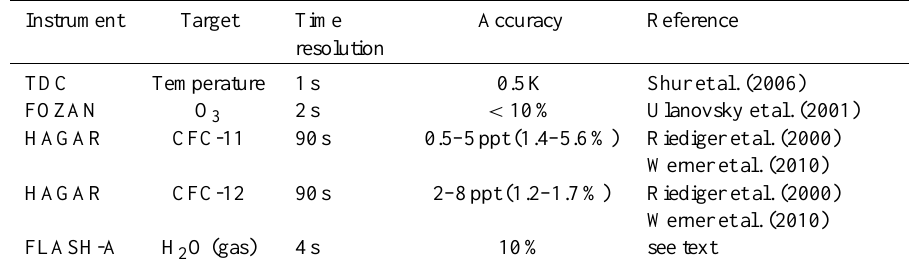
Table 3. In-situ instruments onboard the Geophysica used for comparisions with